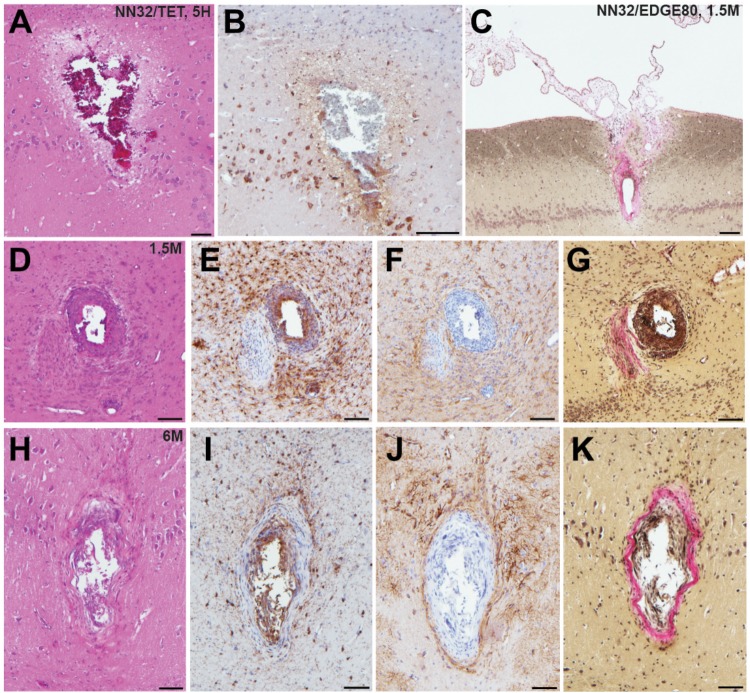
Acute and chronic tissue response to implantation of silicon probes in a large animal. Histopathological responses of multichannel silicon probes were microscopically examined at acute and chronic time points. (A) H&E staining showing silicon probe track with associated hemorrhage acutely (<5 h) following insertion of NN32/TET electrode. (B) APP immunohistochemistry showing the same region as (A). Note the axonal swellings indicative of axonal transport interruption, likely secondary to axonal transection during insertion. Surrounding pyramidal neurons also show increased APP immunoreactivity. (C) Van Gieson stain showing silicon probe track 1.5 months following implantation of NN32/EDGE80 probe where collagen is pink. Notably, there appears to be choroid plexus abnormally located within the alveus. (D–G) Neuropathological findings in NN32/TET silicon probe track, 1.5 months following implantation, demonstrating (D) lesion with (E) IBA-1 positive cells displaying morphological features of activated microglia, (F) GFAP immunoreactive cells with features of reactive astrocytes and (G) Van Gieson staining demonstrating the presence of collagen (pink). (H–K) Silicon probe track 6 months following implantation of NN32/TET, again showing surrounding activation of both microglia (I) and astrocytes (J), as well as the presence of collagen (K). Scale bars: (A,B,D–K): 100 μm; (C): 200 μm.